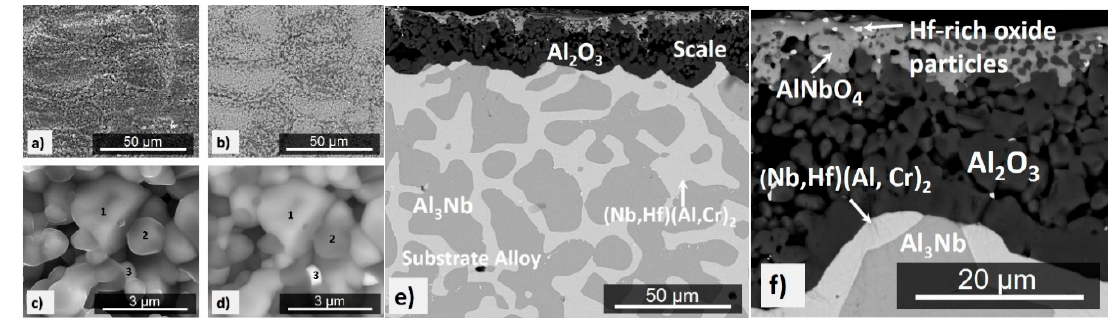
Figure 10. The alloy OHC3 after isothermal oxidation in air at 1300 °C for 100 h. (a) to (d) scale surface, (a) SE image, X2500, (b) BSE image, X2500, (c) SE image, X40000, and (d) BSE image, X40000. (d) and (f) BSE images of cross-sections (e) X1000, and (f) X6000. For the numbers 1 to 3 in (c) and (d) see text.